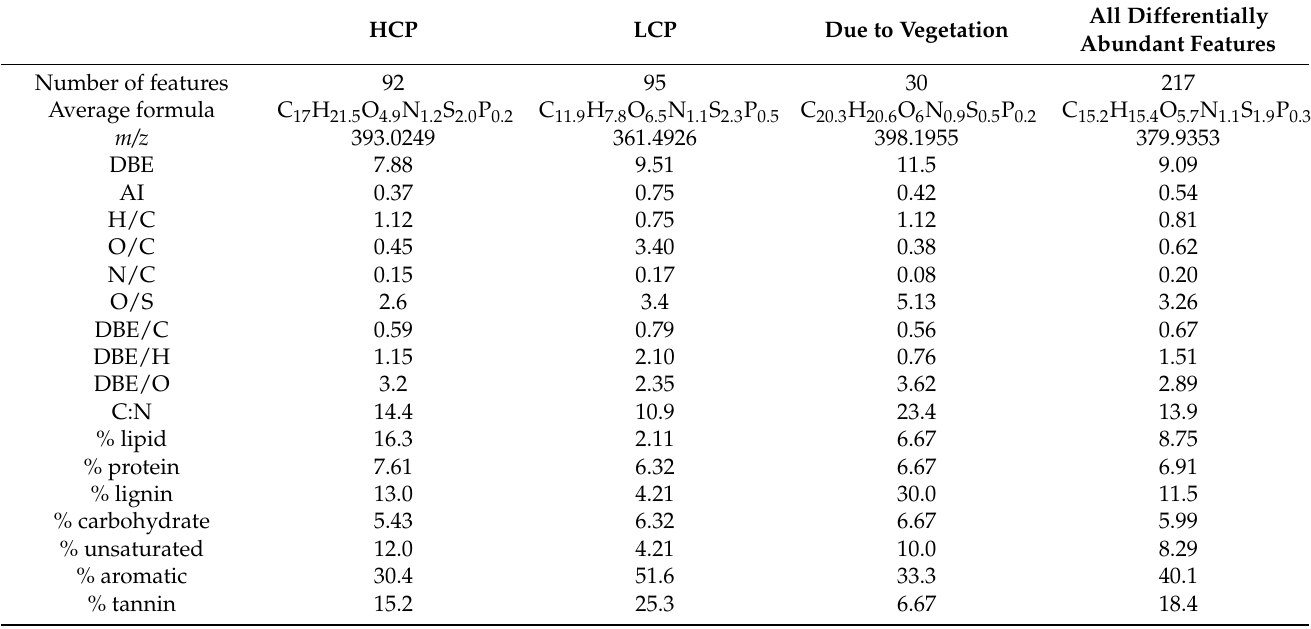
Table 2. Average molecular properties for HQFs that were in higher relative abundance due to polygon type or vegetation. HCP LCP Due to Vegetation